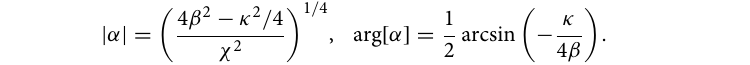
Figure 2. Time dependence of the fidelities, F respectively. The used parameters are χ/ 2 π is approximately 1.38